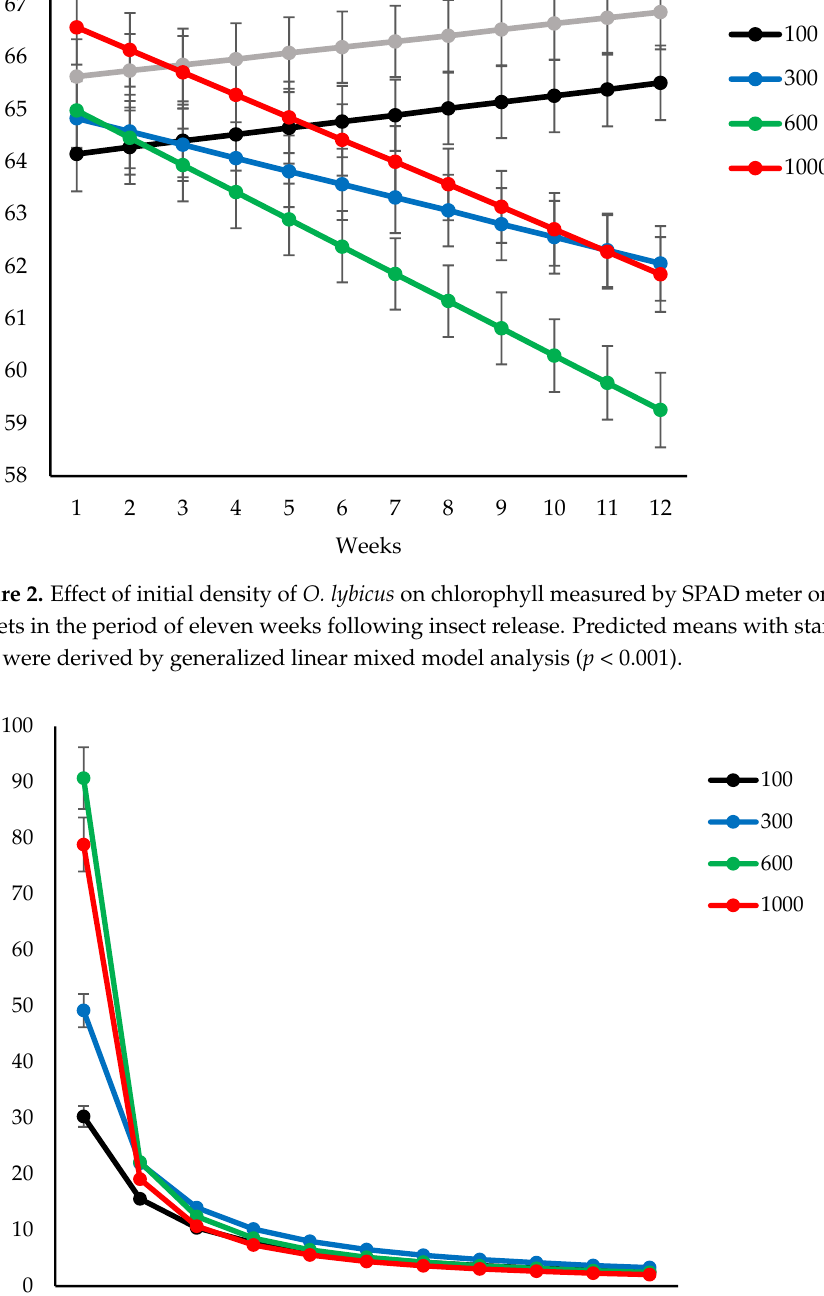
Figure 4. Oviposition site preference (proportion of total eggs per cm − 2 palm area) of O. lybicus . Predicted means with standard error bars were derived by generalized linear model with binomial distribution with link function of logit ( p < 0.001).